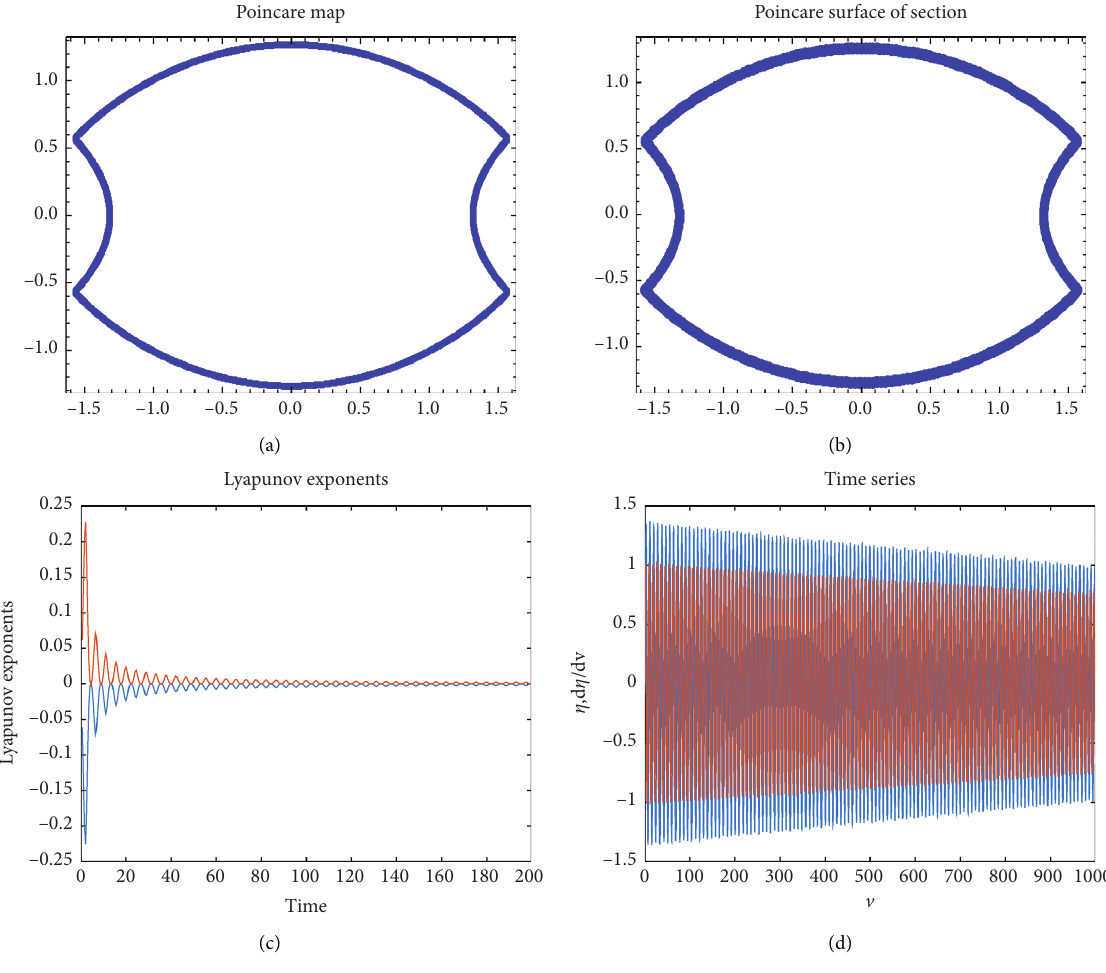
Figure 9: For n � 0 . 8 , ε � 0 . 000000000000000000005 , A E � 200 . 1022 , and e � 0 . 001. (a) Poincare map, (b) Poincare surface of section, (c) Lyapunov exponent, and (d) time ∗